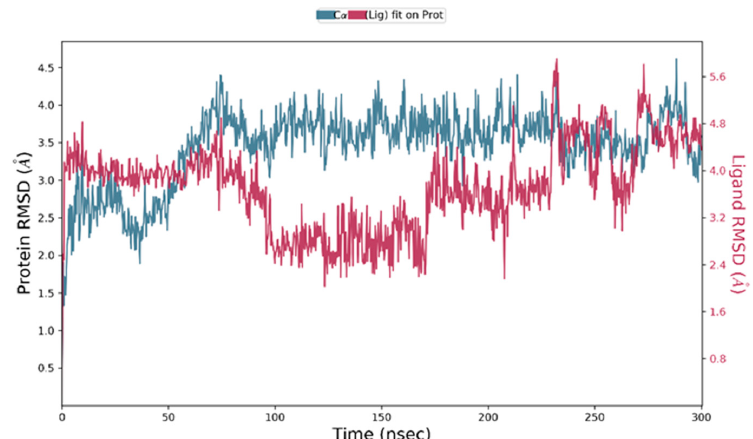
Figure 9. Root mean square deviation of 2,2-diphenyl-1,3-benzodioxole with MAGE-A.